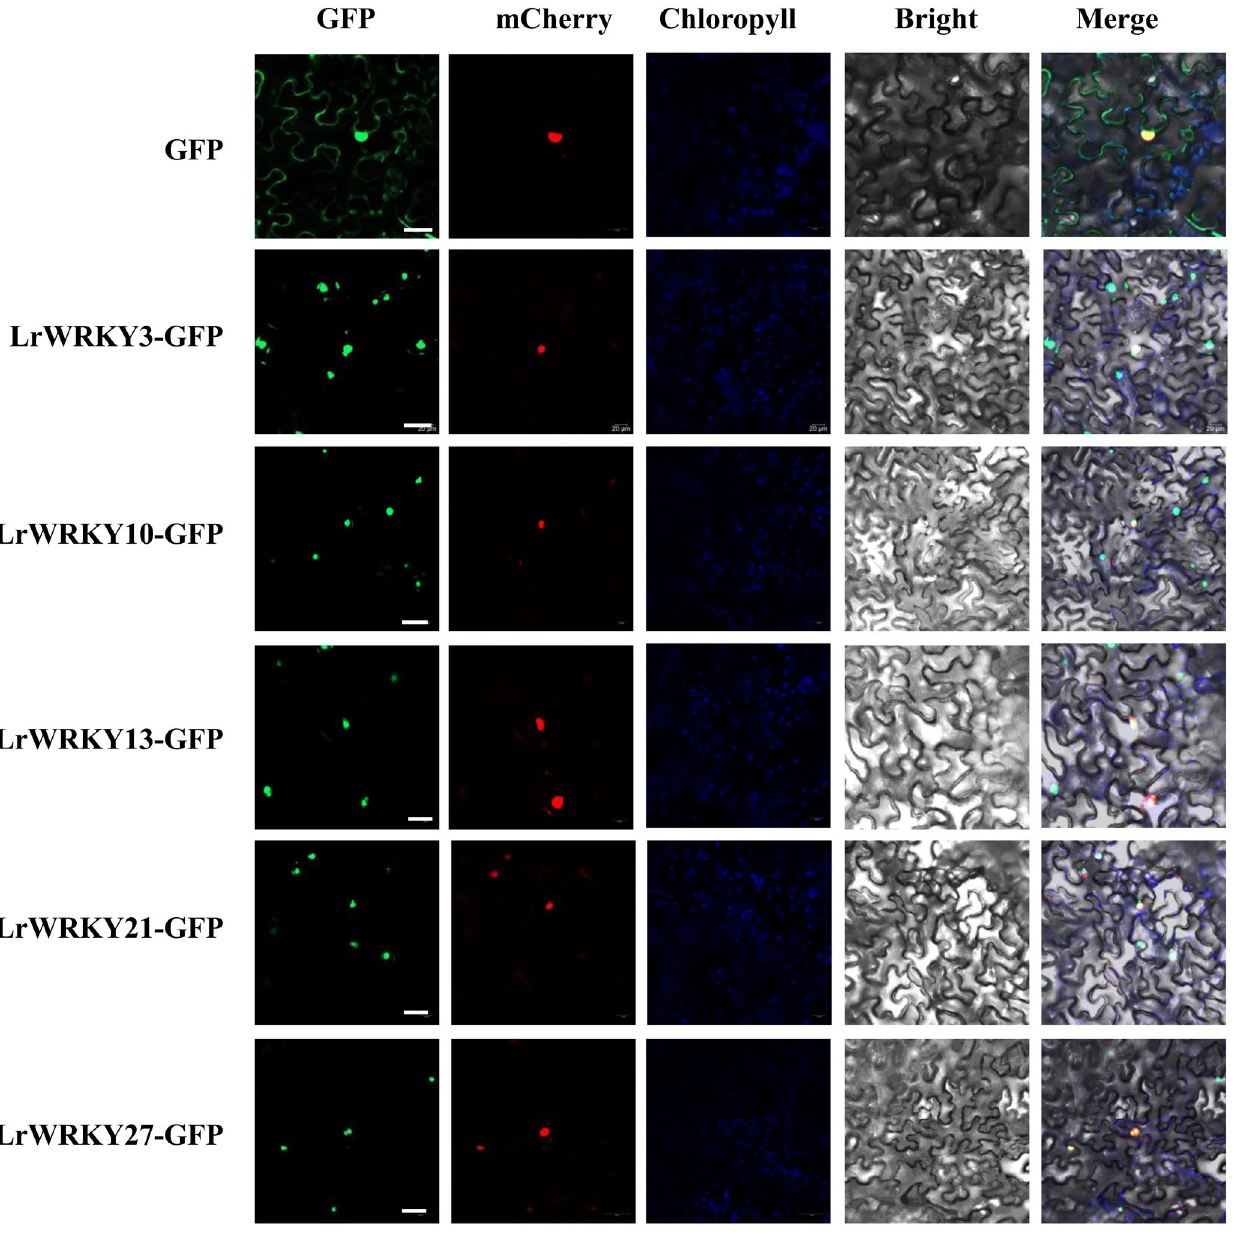
Figure 10. Subcellular localization of LrWRKYs with GFP as a control, which were transiently expressed in N. benthamiana leaves. The photographs were taken using the green channel (GFP fluorescence), red channel (nuclear marker protein AtCOL), blue channel (chlorophyll represents chlorophyll auto fluorescence), bright channel, and their combination under a confocal microscope. Merged bright-field, green fluorescence, red fluorescence, blue fluorescence, and green—red—blue fluorescence images. Scale bar = 10 μm.